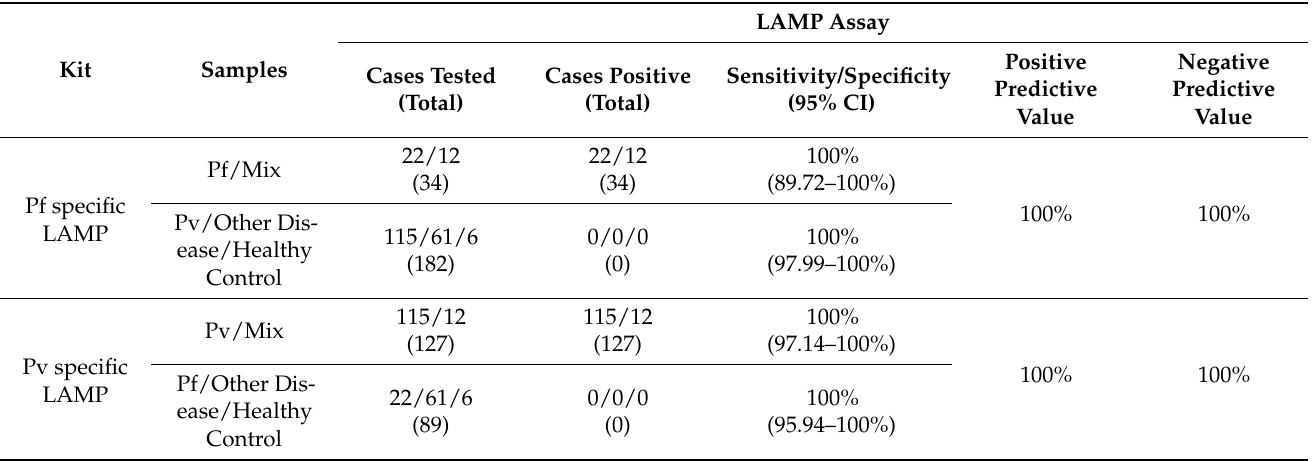
Table 2. Diagnostic performance parameters of two-tube LAMP assay for differential diagnosis of P. falciparum and P. vivax using clinical